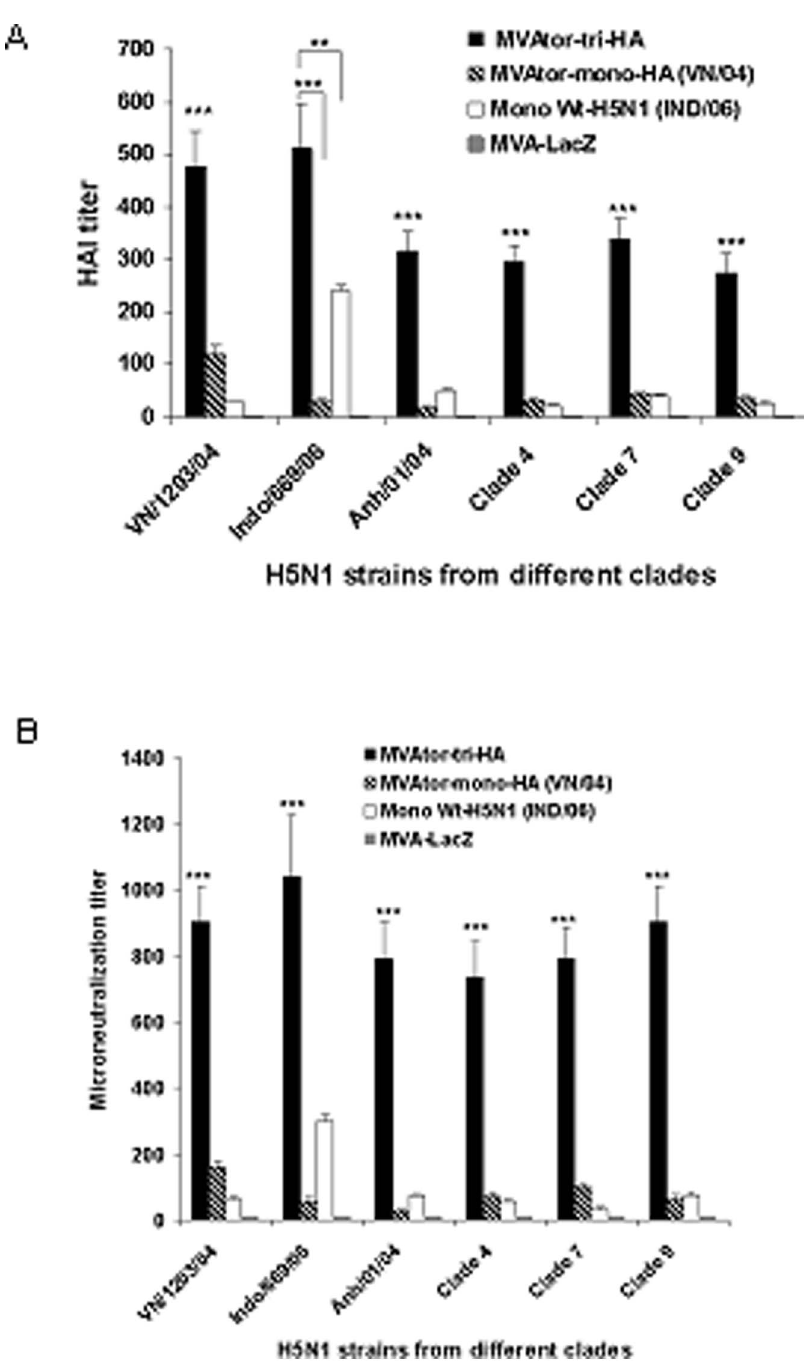
Figure 3. HAI and VMN titers against H5N1 strains. The specific immune responses of mice immunized i.m. on days 0 and 28 with MVAtor-tri- HA or MVAtor-mono-HA (A/Vietnam/1203/04) or MVA-LacZ vector. A reference group of mice was vaccinated s.c. with adjuvanted inactivate H5N1 viral vaccine (A/Indonesia/CDC669/06). Serum hemagglutination inhibition (HAI) assay (A). The serum HAI titer on day 47 against homologous H5N1 strains, clade 1 (RG-A/Vietnam/1203/04), clade 2.1.3.2 (A/Indonesia/CDC669/06), clade 2.3.4 (RG-A/Anhui/01/2005) and heterologous H5N1 strains from clade 4 (RG-A/goose/Guiyang/337/2006), clade 7 (RG-A/chicken/Shanxi/2/2006) and clade 9 (RG-A/chicken/Henan/12/2004). Each point represents the geometric mean titer (n=10) 6 SE. (**P , 0.01; ***P , 0.001). Serum virus microneutralization (VMN) assay on day 47 against homologous and heterologous H5N1 strains (B). Each point represents the geometric mean titer (n=10) 6 standard error (SE). (***P , 0.001).